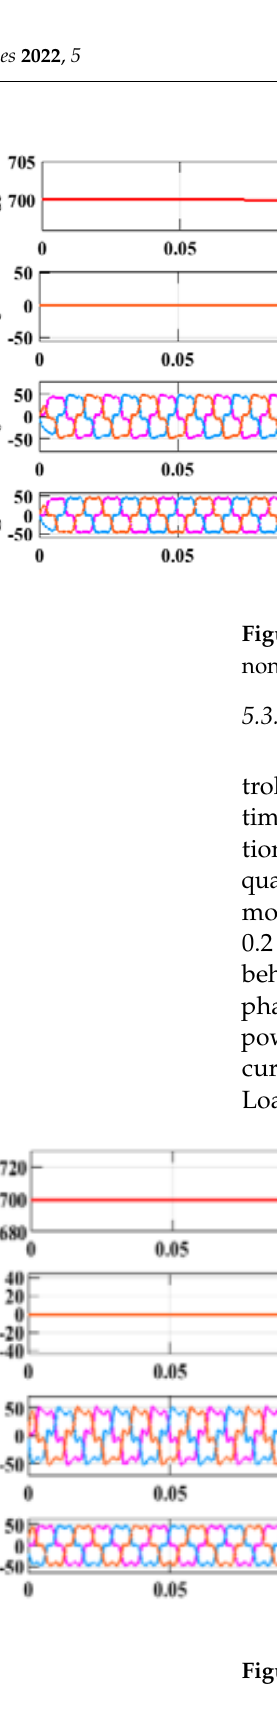
-based DSTATCOM in current source-based non-linear load. Figure 18. The behavior of Icos 𝜽𝜽